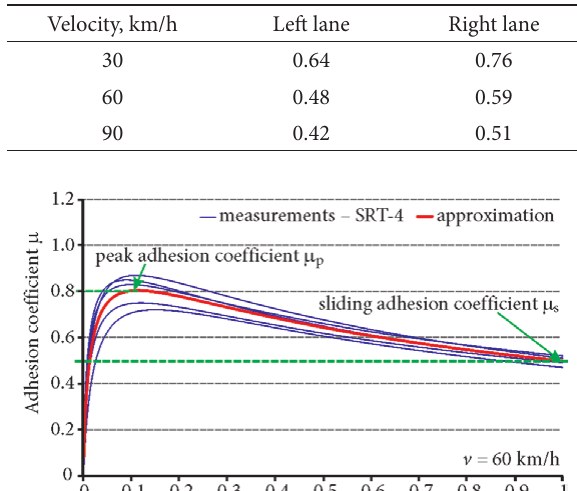
Table 2. Adhesion coefficients µ s on the road made in SMA technology